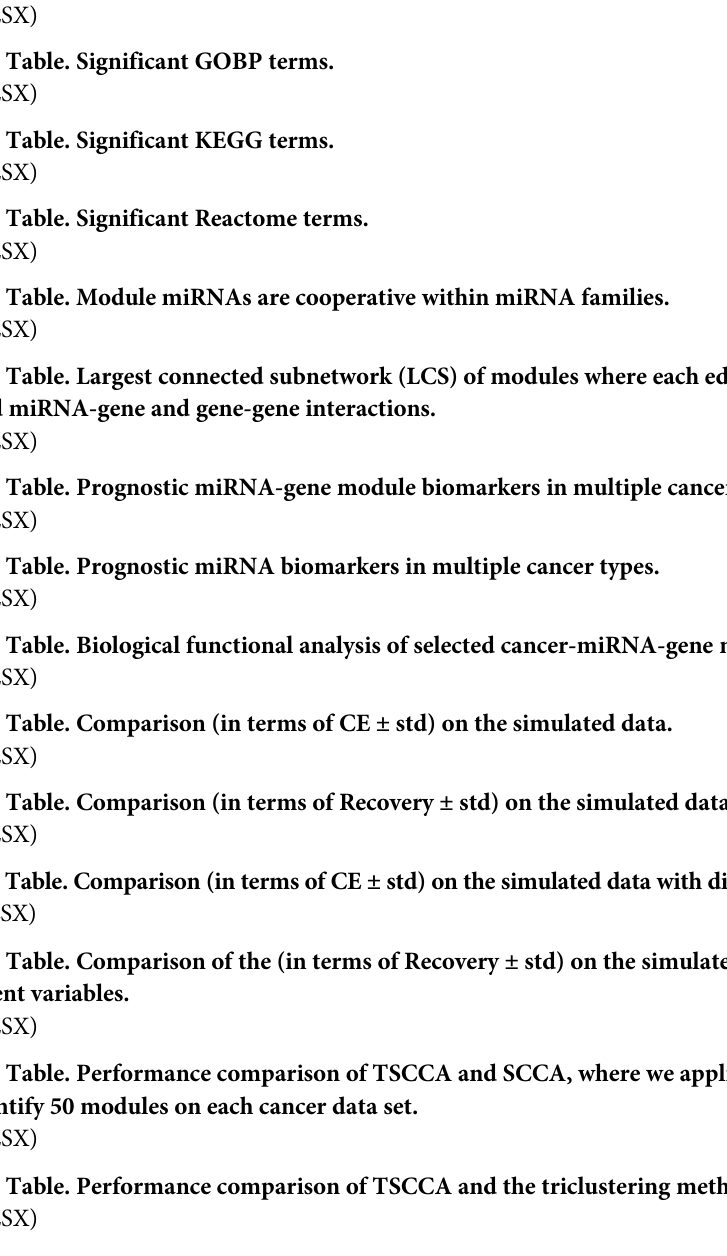
S13 Table. Significant KEGG terms. S14 Table. Significant Reactome terms. S15 Table. Module miRNAs are cooperative within miRNA families. S16 Table. Largest connected subnetwork (LCS) of modules where each edge is from veri- fied miRNA-gene and gene-gene interactions. S17 Table. Prognostic miRNA-gene module biomarkers in multiple cancer types. S18 Table. Prognostic miRNA biomarkers in multiple cancer types. S19 Table. Biological functional analysis of selected cancer-miRNA-gene modules. S20 Table. Comparison (in terms of CE ± std) on the simulated data. S21 Table. Comparison (in terms of Recovery ± std) on the simulated data. S22 Table. Comparison (in terms of CE ± std) on the simulated data with different variances. (XLSX) S23 Table. Comparison of the (in terms of Recovery ± std) on the simulated data with dif- ferent variables. S24 Table. Performance comparison of TSCCA and SCCA, where we applied SCCA to identify 50 modules on each cancer data set. S25 Table. Performance comparison of TSCCA and the triclustering methods. S26 Table. Results of pcModule. S27 Table. Gene-gene interaction set enrichment for the identified modules by TSCCA on the TCGA data. S28 Table. miRNA-gene interaction set enrichment for the identified modules by TSCCA on the TCGA